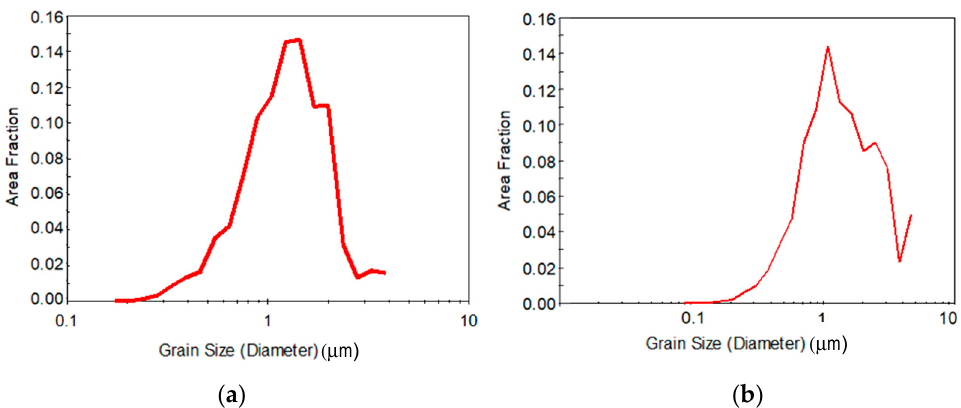
Figure 7. Distribution of the grain size after the maximum number of passes with a pre-annealing at ( a ) low temperature and ( b ) high temperature.